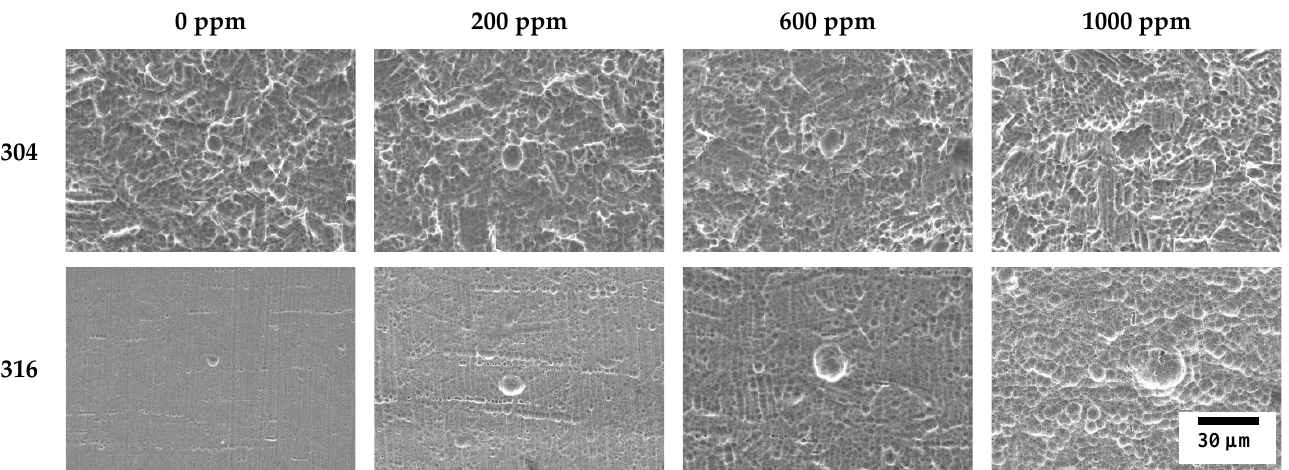
Figure 11. Surface morphologies of damaged surface for 304 and 316L stainless steels after a poten- tiodynamic polarization experiment.